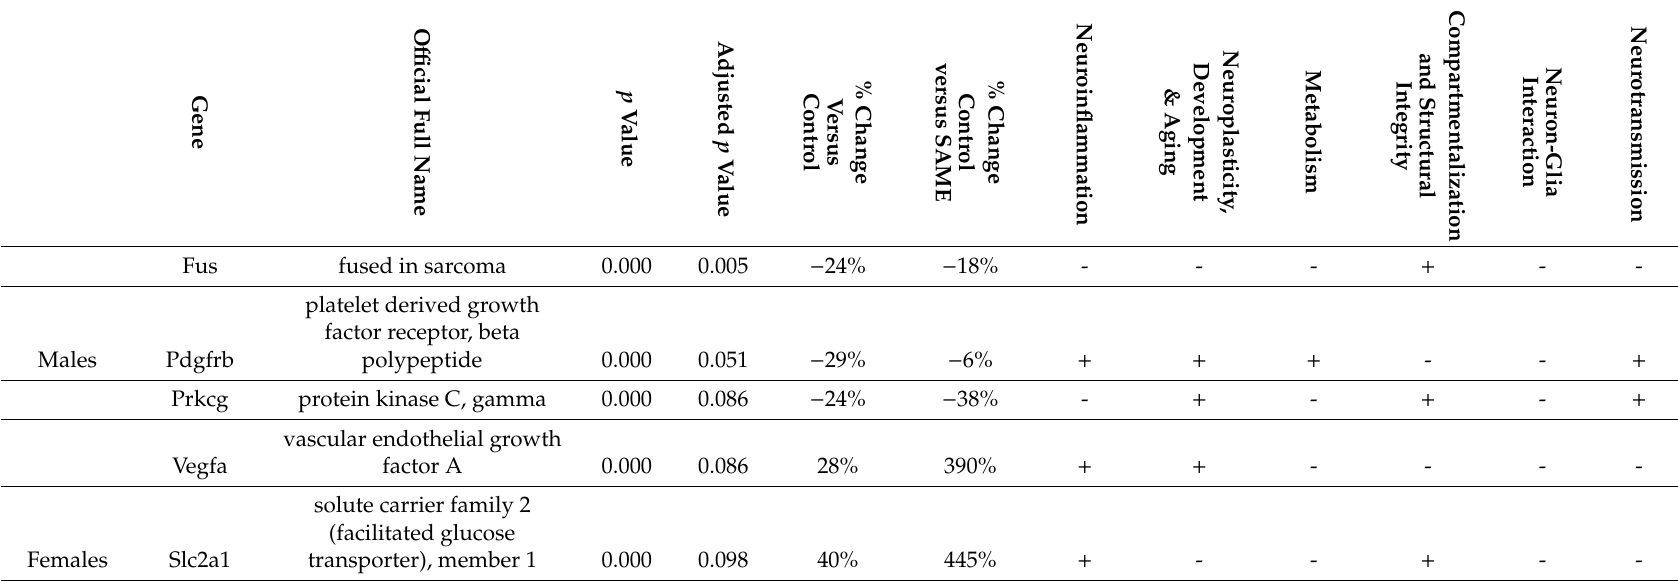
Table 7. Genes significantly changed in males and females by co-administration of SAMe and